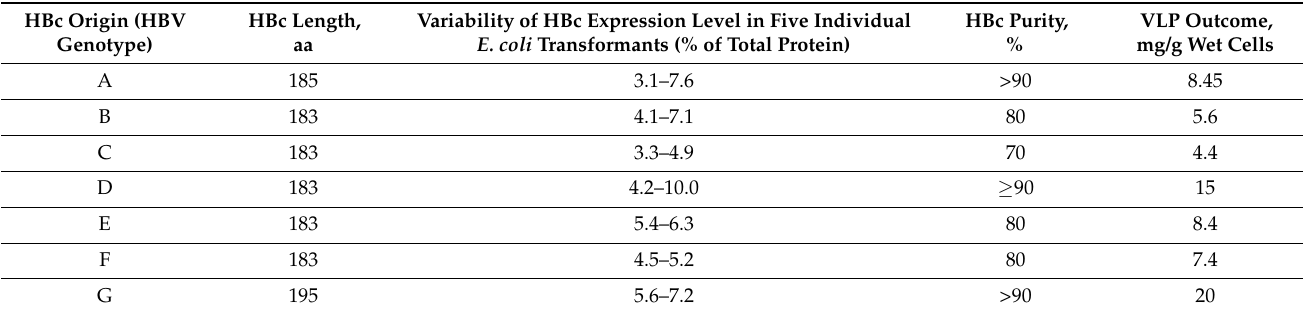
Table 1. Characterization of expression of HBc proteins from different HBV genotypes. The HBc purity is shown for the expression culture obtained from the best